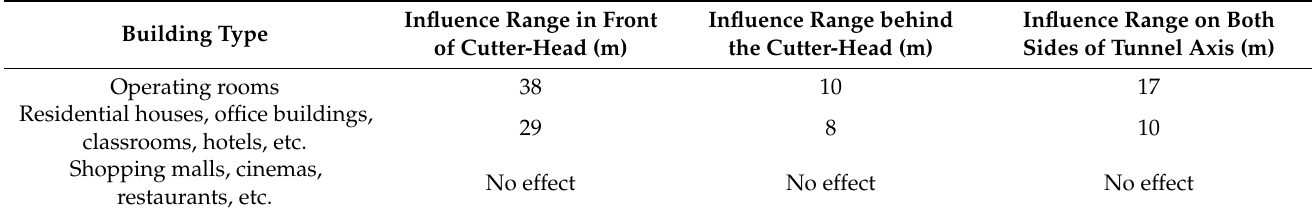
Table 5. The vibration influence range of double-shield TBM